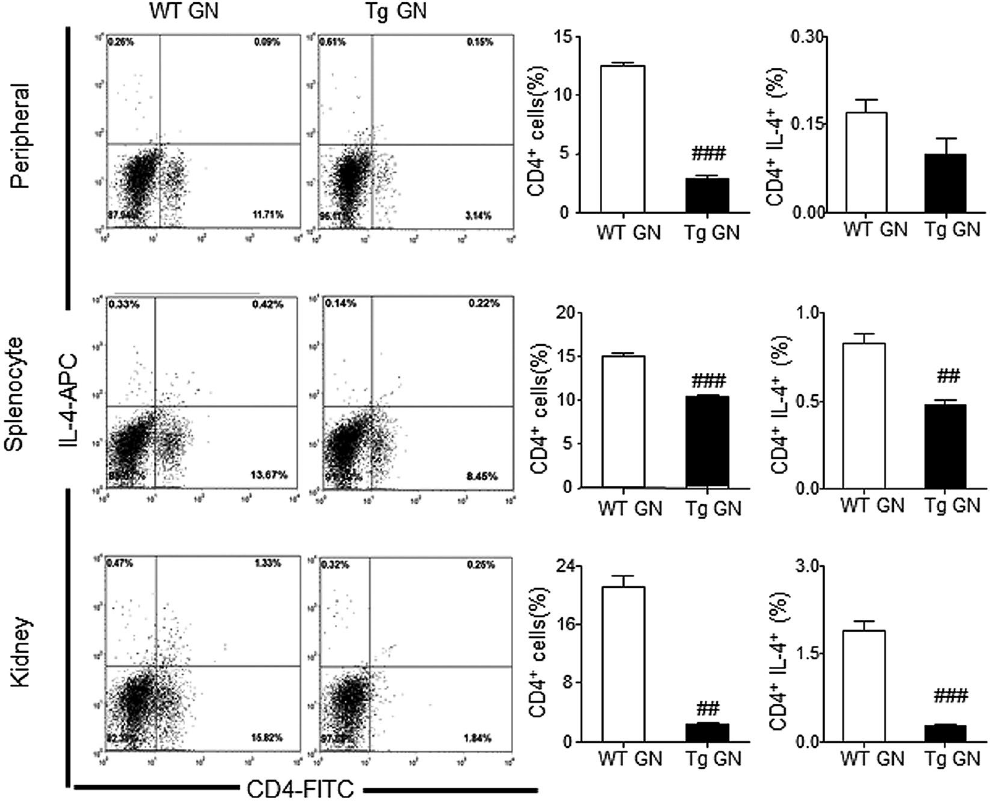
Figure 7. Systemic and renal infiltrated CD4 + IL-4 + Th2 cells are decreased in Foxp3 Tg mice when compared with WT mice. Flow cytometry analysis of peripheral and splenic and renal infiltrated CD4 + IL-4 + Th2 cells from diseased WT and Tg mice. Each bar represents mean ± SEM. ## p < 0.01 and ### p < 0.001 compared with the WT mice. n = 3 mice per